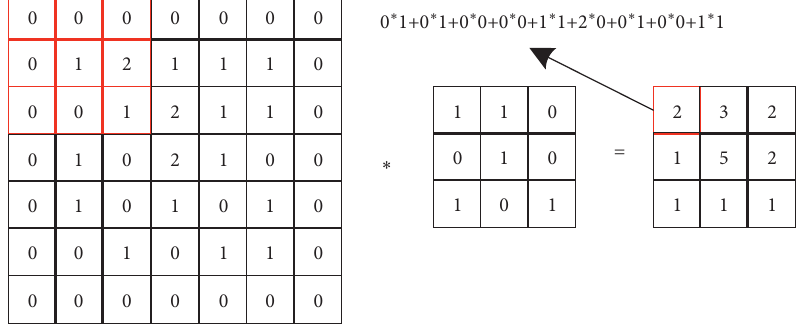
Figure 3: Convolution calculation